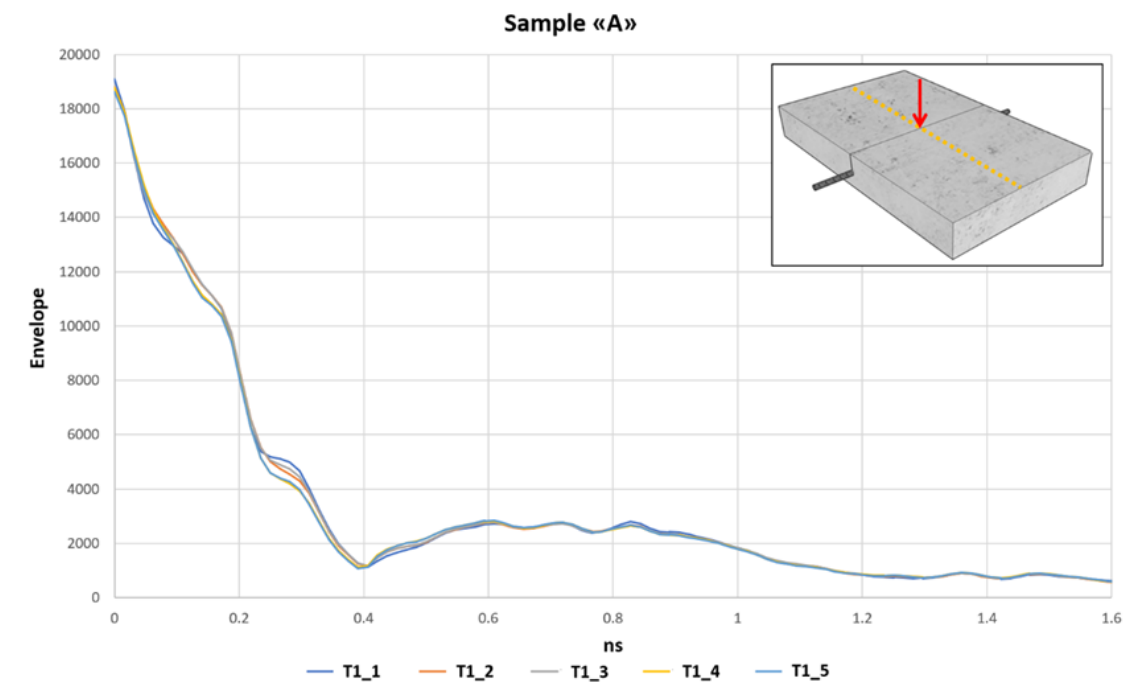
Figure 7. Envelope A-scan acquired on the sample “A.” The trace shown is taken from radargram 29, which is exactly in the middle of the concrete sample. The track considered is above the steel rebar present at 0.6 ns. The trace remains constant during the 5 days of investigation, T1_1 at T1_5.